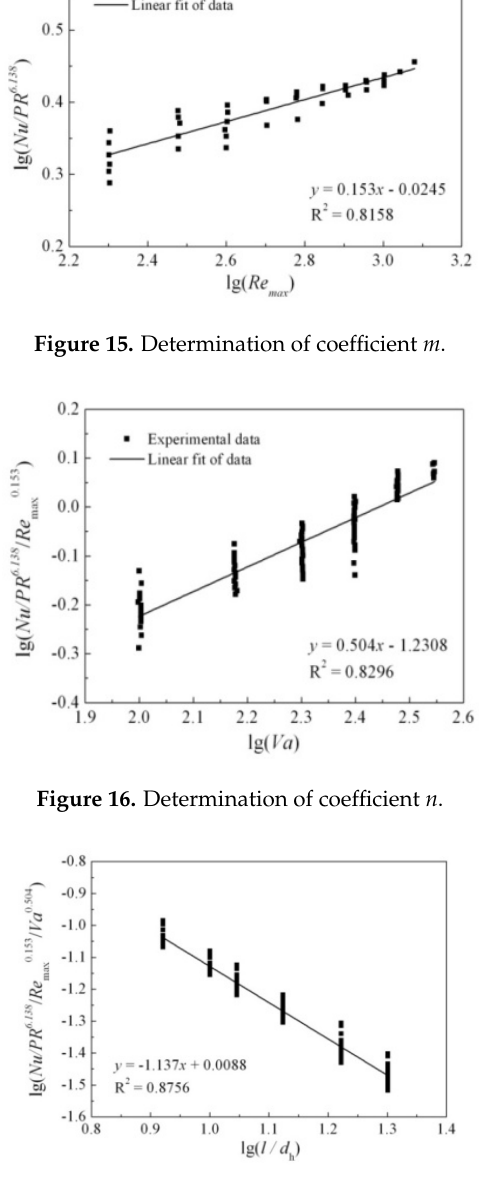
Figure 14. Determination of coefficient b .